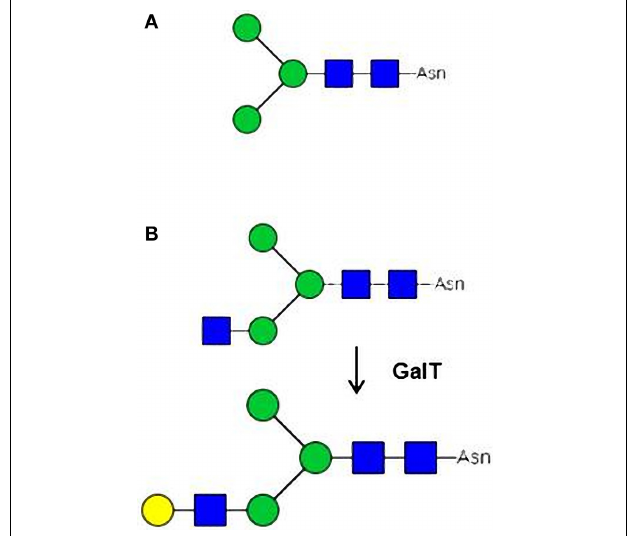
FIGURE 3 | Engineering of the N- linked glycans associated to biopharmaceuticals. (A) Man-3 oligomannoside N-linked to the recombinant glucocerebrosidase used for Enzyme Replacement Therapy in patients suffering from Gaucher’s disease, a lysosomal storage disease. (B) Trapping in the Golgi apparatus of intermediate GlcNAc-terminated N-glycans by expression of a mammalian β (1,4)-galactosyltransferase (GalT). Mannose Galactose